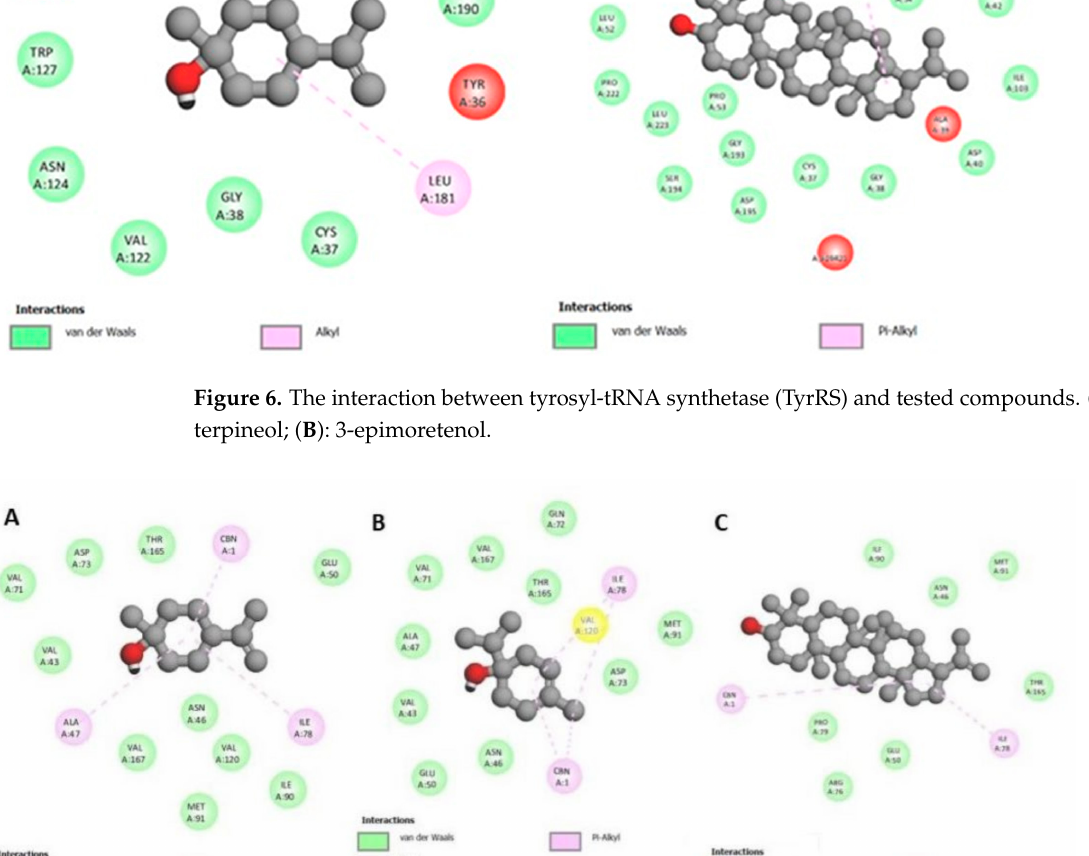
Figure 7. The interaction between DNA gyrase and tested compounds. ( A ): Beta-terpineol; ( B ): Ter- pinen-4-ol (C): 3-epimoretenol.